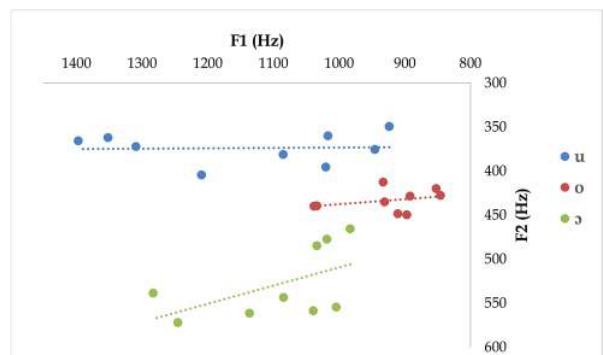
Figure 8. Scatter plot of back vowel formant frequencies